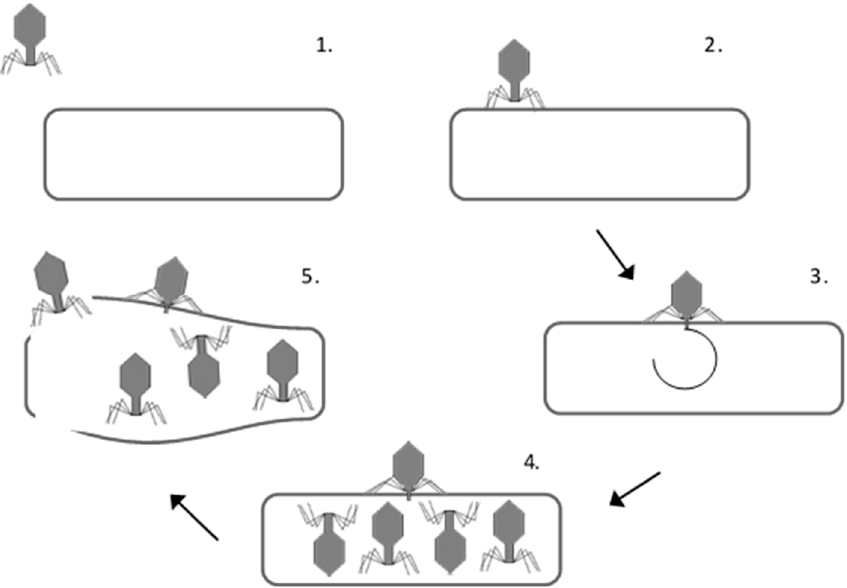
Figure 1. Life cycle of a virulent tailed phage (not to scale). (1) The phage collides with the bacterial cell; (2) the phage binds to cell receptors; (3) the phage is irreversibly bound and injects nucleic acid into the cell via the tail tube, where it is transcribed and translated; (4) many progeny phages are produced within intact cells; (5) endolysins degrade the host bacterial cell wall, which loses its structural integrity and ruptures due to the osmotic pressure, releasing the progeny phages. Endolysins are predominantly more effective against Gram-positive bacteria than Gram-